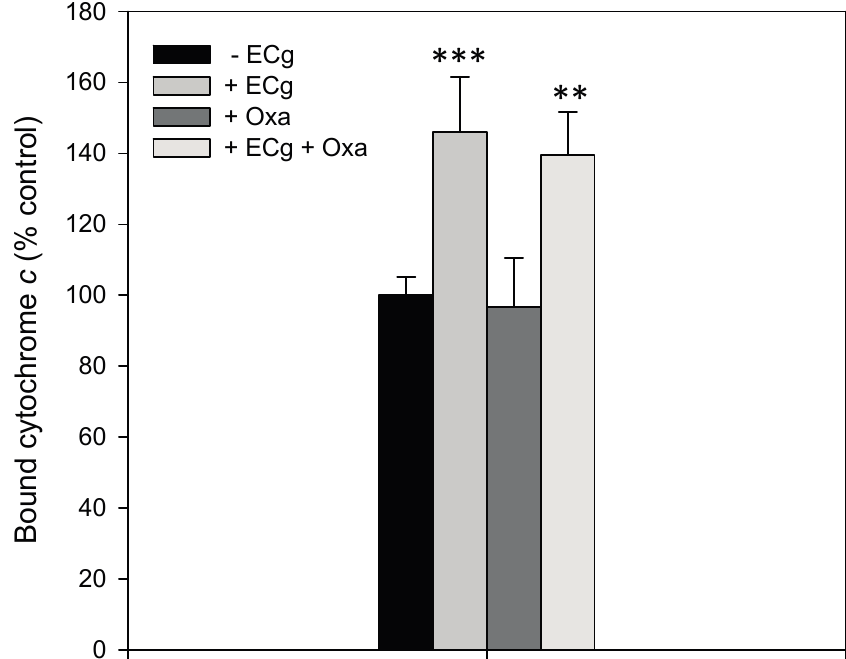
Figure 2. Growth of EMRSA-16 in MH broth containing 12.5 µg/mL ECg increases surface binding of the cationic protein cytochrome c. ECg-exposed and control cells were suspended (OD 600 7.0) in 3-( N -morpholino)propanesulfonic acid (MOPS) buffer (20 mM, pH 7.0) at 37 °C for 10 min together with 0.5 mg/mL cytochrome c. The remaining (unbound) cytochrome c in the supernatant was quantified spectrophotometrically